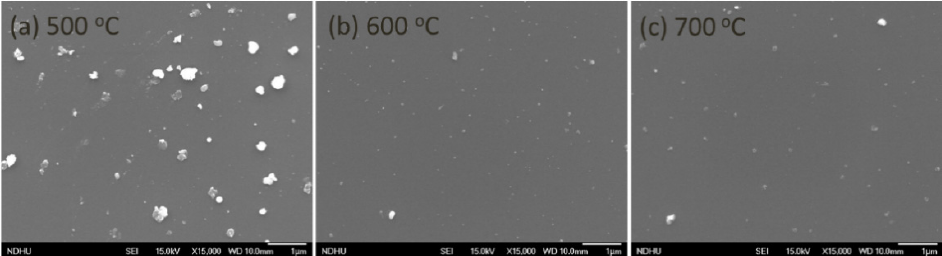
Figure 3. SEM images of GaN films grown at different growth temperatures: ( a ) T1: 500 °C, ( b ) T2: 600 °C and ( c ) T3: 700 °C.